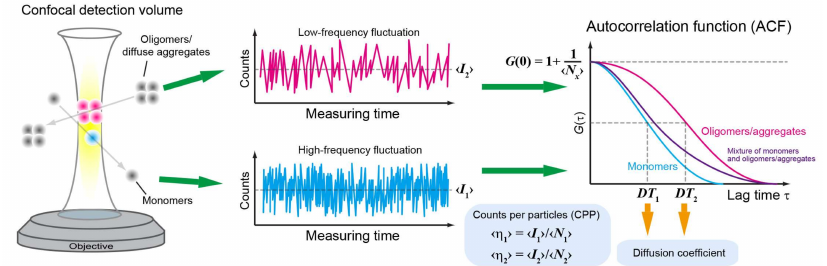
Figure 1. Overview of fluorescence correlation spectroscopy (FCS). Overview of FCS measurement and analysis. ‹ I 1 › and ‹ I 2 › represent the average fluorescence intensity of monomers and oligomers/soluble aggregates, respectively. Diffusion times ( DT 1 and DT 2 ) and the number of molecules (‹ N x ›) are obtained from the autocorrelation function (ACF) of the fluctuation. Counts per particle (CPP: ‹ η 1 › or ‹ η 2 ›) are calculated using the mean fluorescence intensity during the measurement and the number of molecules. Colors: cyan (monomers), magenta (oligomers/aggregates), and purple (mixture of monomers and oligomers/aggregates;